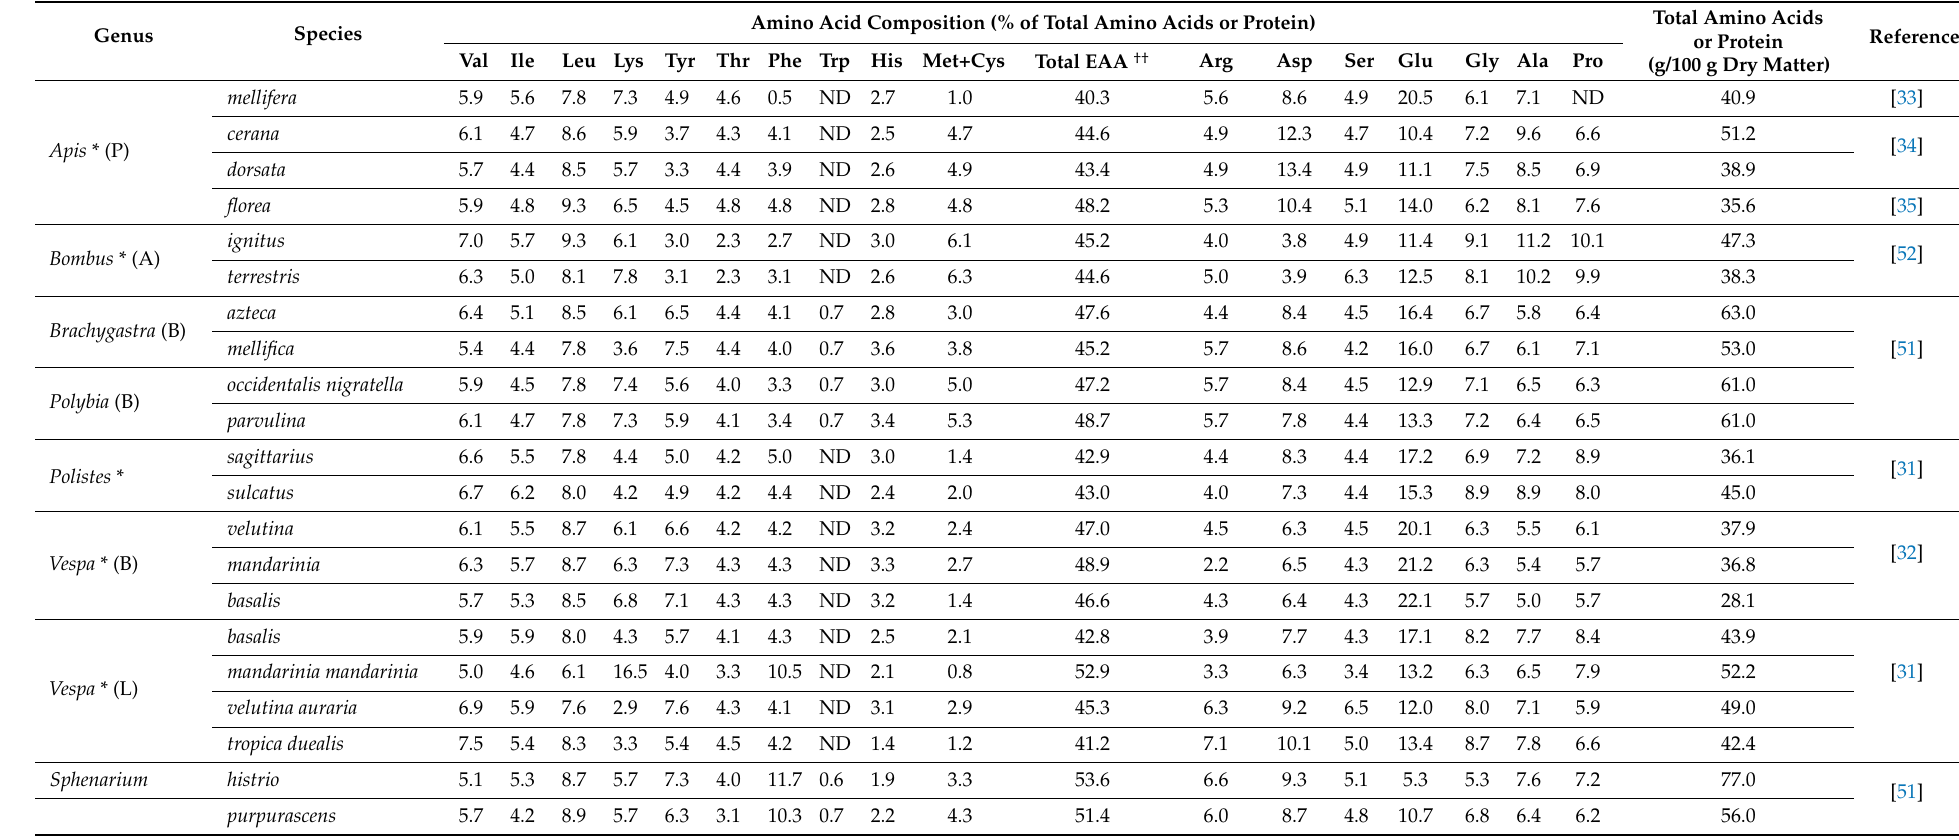
Table 3. Amino acid composition of different species belonging to the same